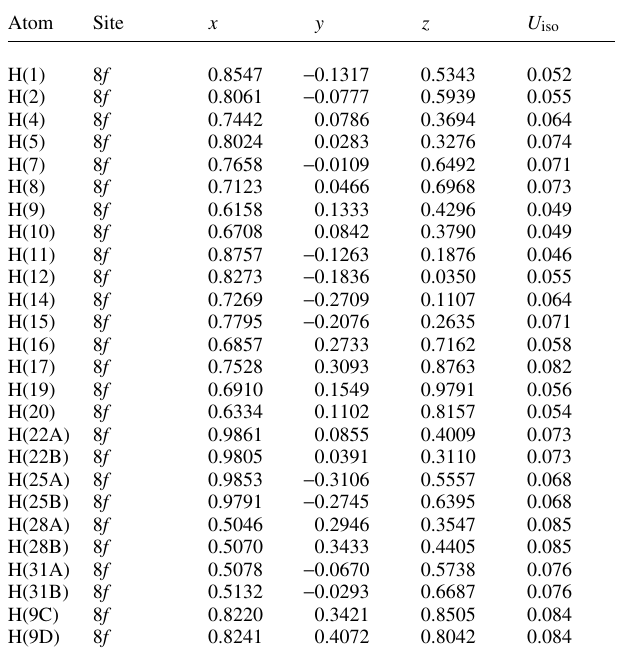
Table 2. Atomic coordinates and displacement parameters (in Å 2 ) .